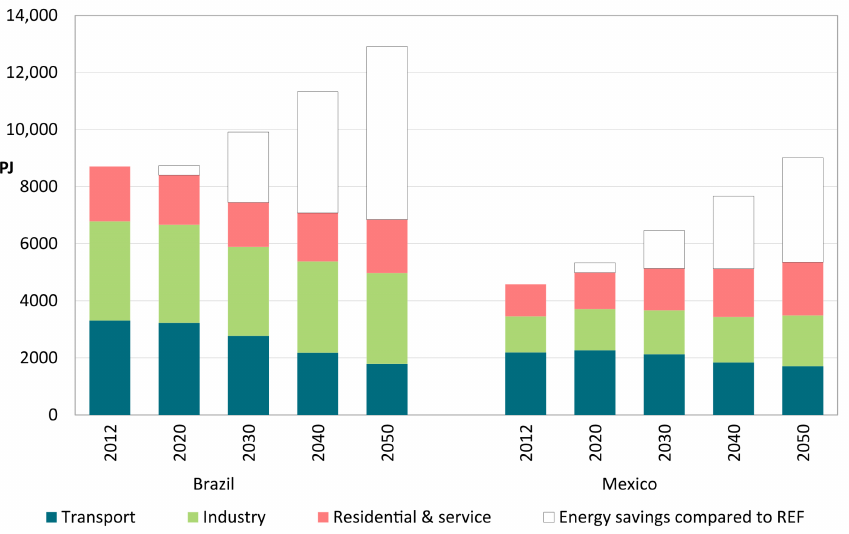
Figure 2. Final energy demand by sectors in Mexico and Brazil in E[R] compared to